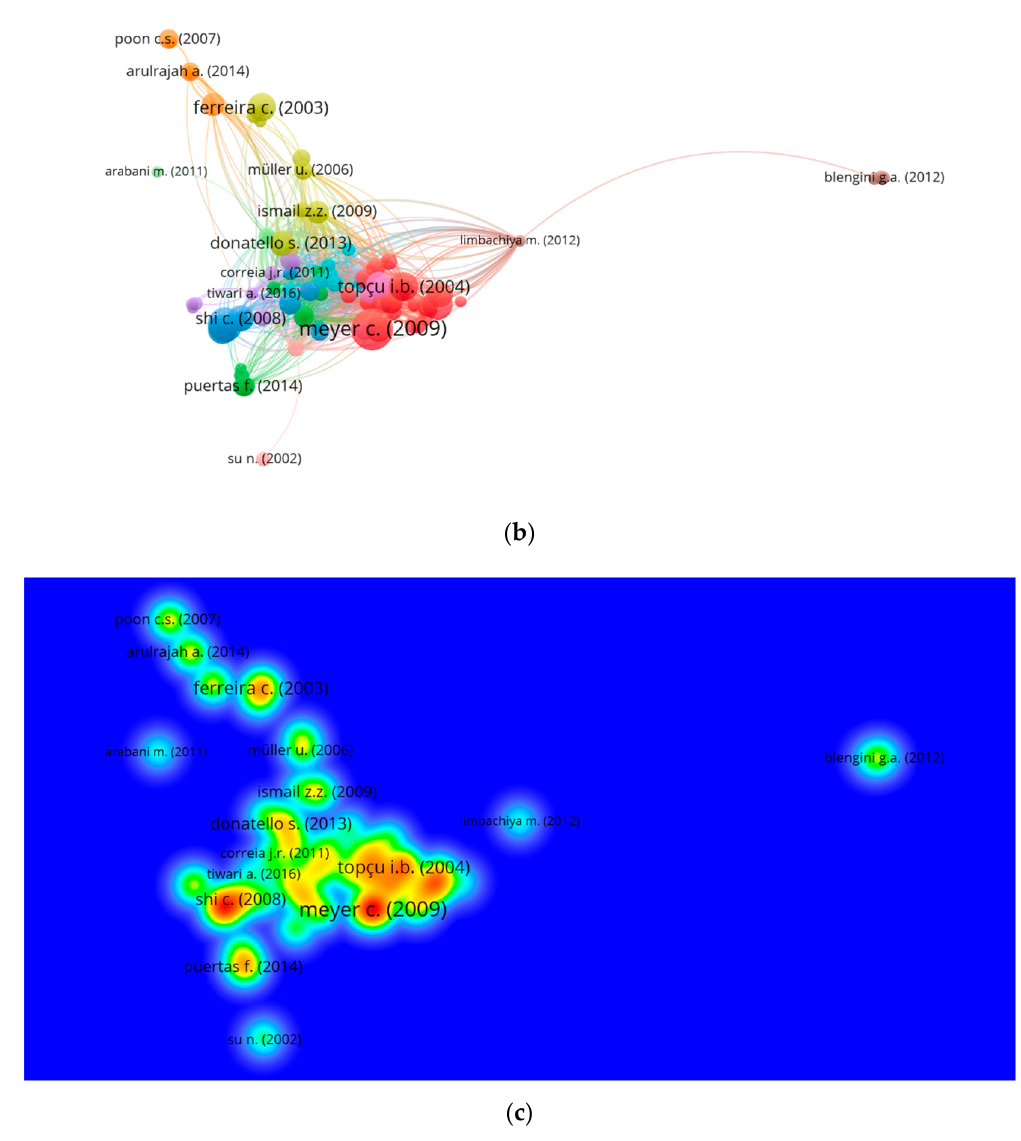
Figure 8. Mapping of documents; ( a ) documents with minimum 100 citations; ( b ) connected documents based on citations; ( c ) density of connected documents.